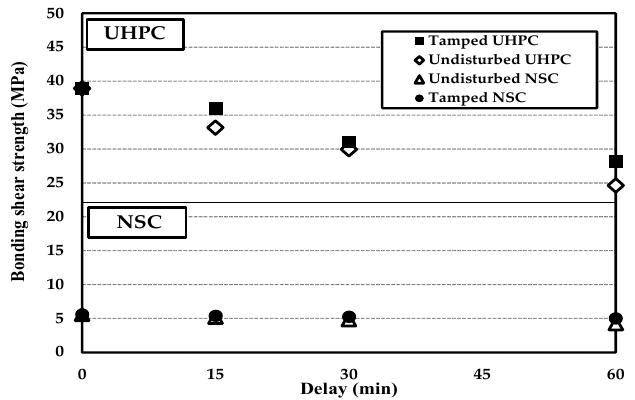
Figure 5. Comparison of bonding shear strengths of NSC and UHPC with tamping and varying delays. Table 8. Results of bonding shear strength